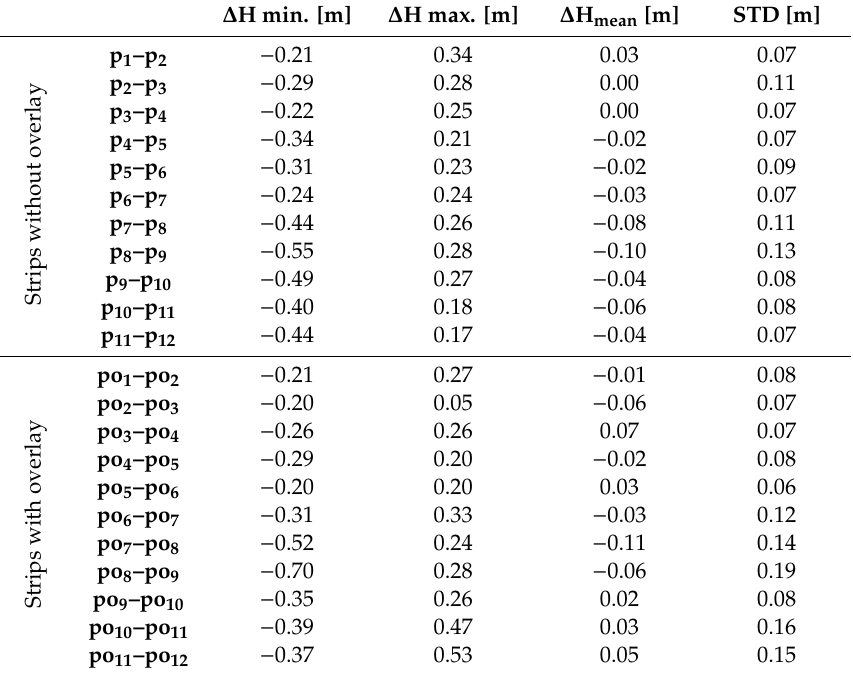
Table 7. Height differences between strips in methodology v2. (Where: H—height, STD—standard deviation). ∆ H min. [m] ∆ H max. [m] ∆ H mean [m] STD [m]